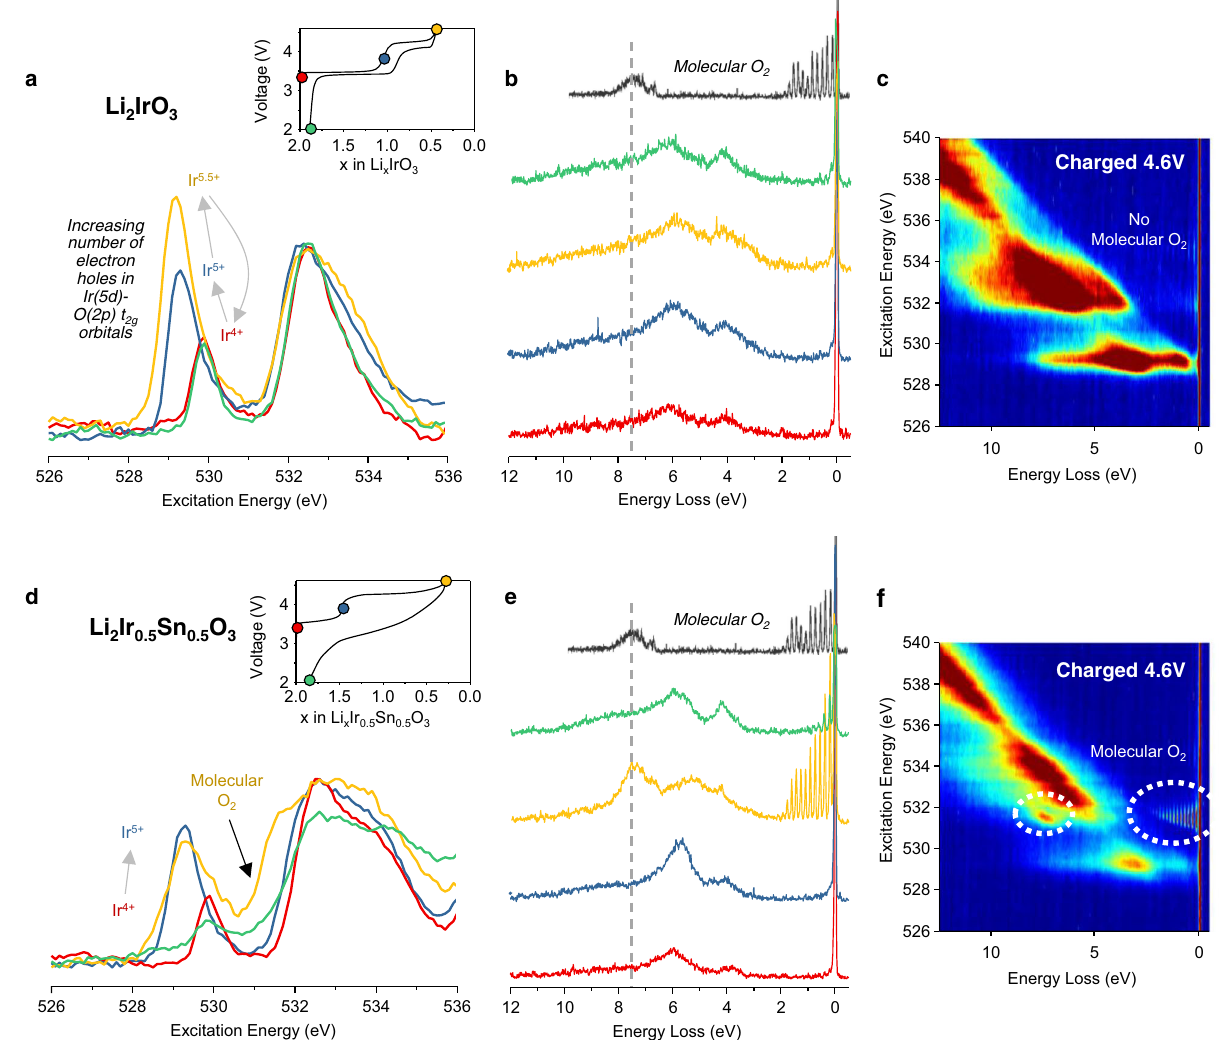
Fig. 3 O XAS and RIXS spectroscopy of Li-rich iridates. a , d O K-edge XAS spectra collected in bulk sensitive partial fl uorescence yield (PFY) mode. Inset fi gure — load curve showing with coloured dots where on the load curve the spectra were collected. b , e High resolution RIXS line scans at an excitation energy of 531 eV. Spectrum of molecular O 2 gas shown for reference in black (reproduced from ref. 35 ). The RIXS line scans reveal the formation of molecular O 2 in Li 2 Ir 0.5 Sn 0.5 O 3 which is reduced to O 2 − on discharge but not in Li 2 IrO 3 . c , f High resolution RIXS maps of the O K-edge pre-edge for cathodes charged to the end of the high voltage plateau. The RIXS maps show that there are no other